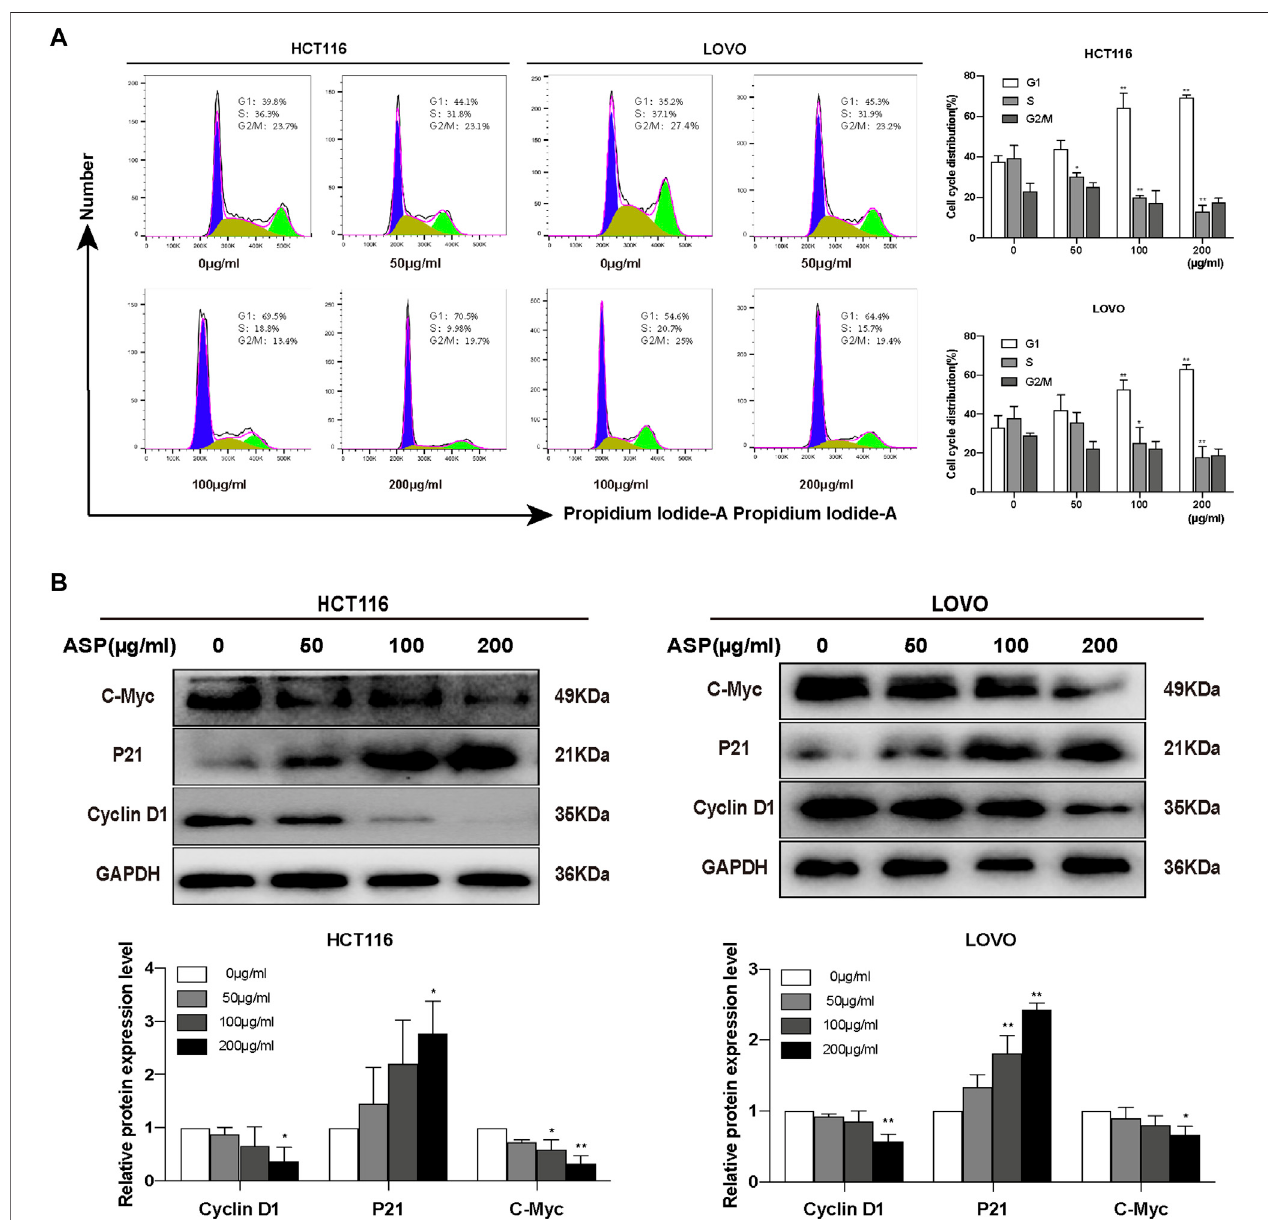
FIGURE6| Asparagus aqueousextract(ASP)signi fi cantlyinhibitsthecellcycleofcolorectalcancercells. (A) ASPsigni fi cantlyinhibitedthecellcycleprogressionof HCT116 and LOVO, stopping them in G1/G0 phase, as shown in fl ow cytometric analysis ( n = 3 per group). (B) Expression of Cyclin D1 and C-Myc decreased with increasing ASP concentration and P21 increased ( n = 3 per group). Values are shown as the mean ± SD, * p < 0.05, ** p < 0.01 vs . the control.